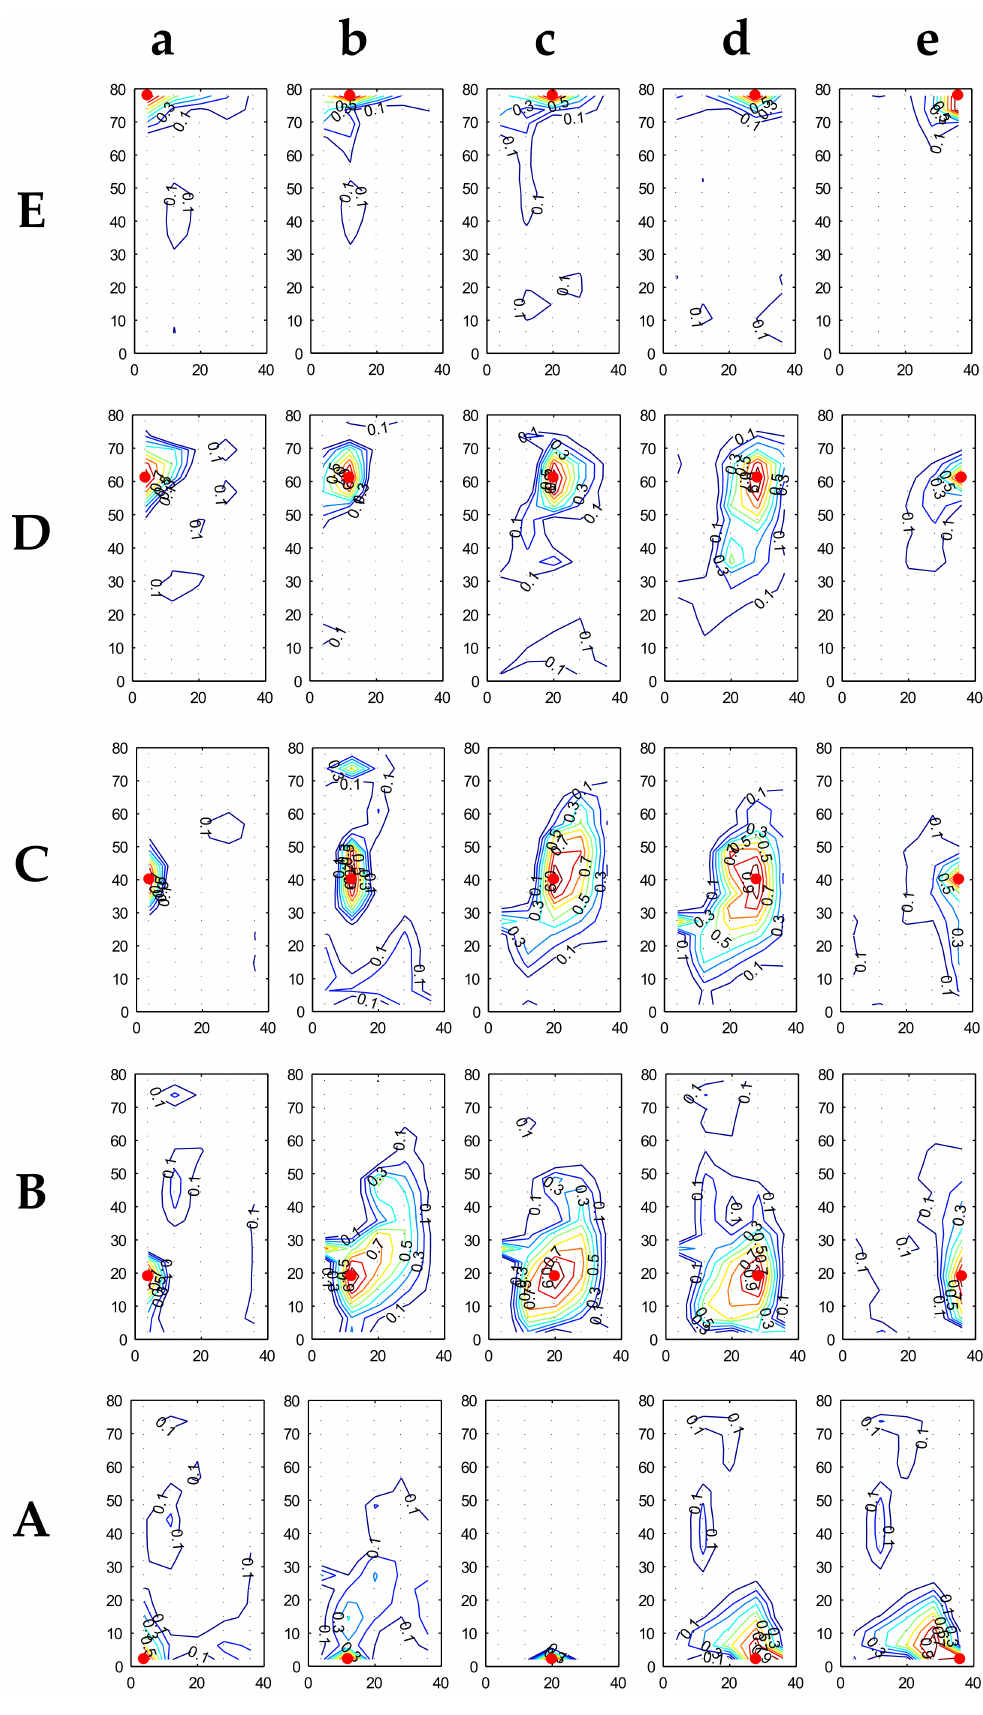
Figure 9. Correlation coefficient trend for RLC at 45 ◦ . Color bar as in Figure